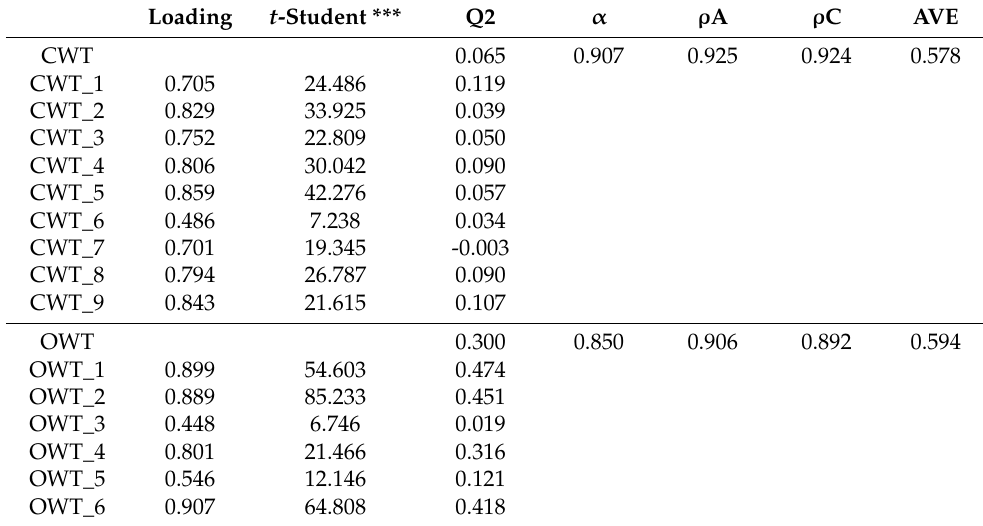
Table 3. Assessment of the measurement model. Estimated constructs in Mode A.